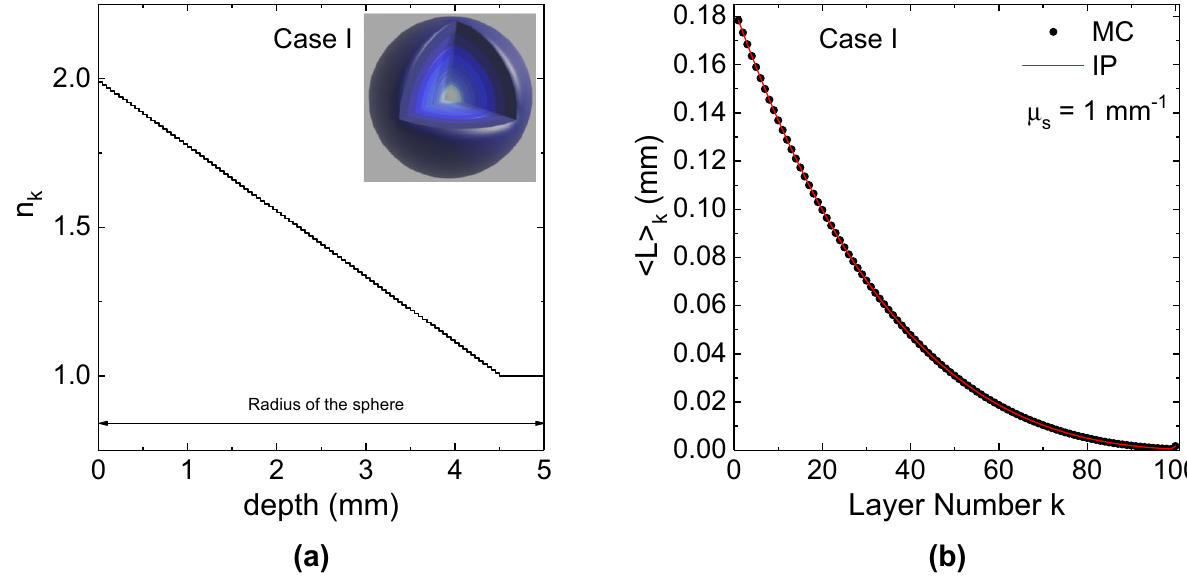
Figure 3. ( a ) Refractive index profile inside the sphere versus the depth from the external surface. ( b ) Partial L k pathlength in each layer is shown for a hundred-layered sphere ( a ) with a refractive index that decreases (cid:31) (cid:30) towards the center. The innermost layer is a sphere of radius 0.5 mm. The MC results shown in figure pertain 10 7 simulated trajectories. Figures created by using OriginPro 2021b Academic (https:// www. origi nlab. to N = com/